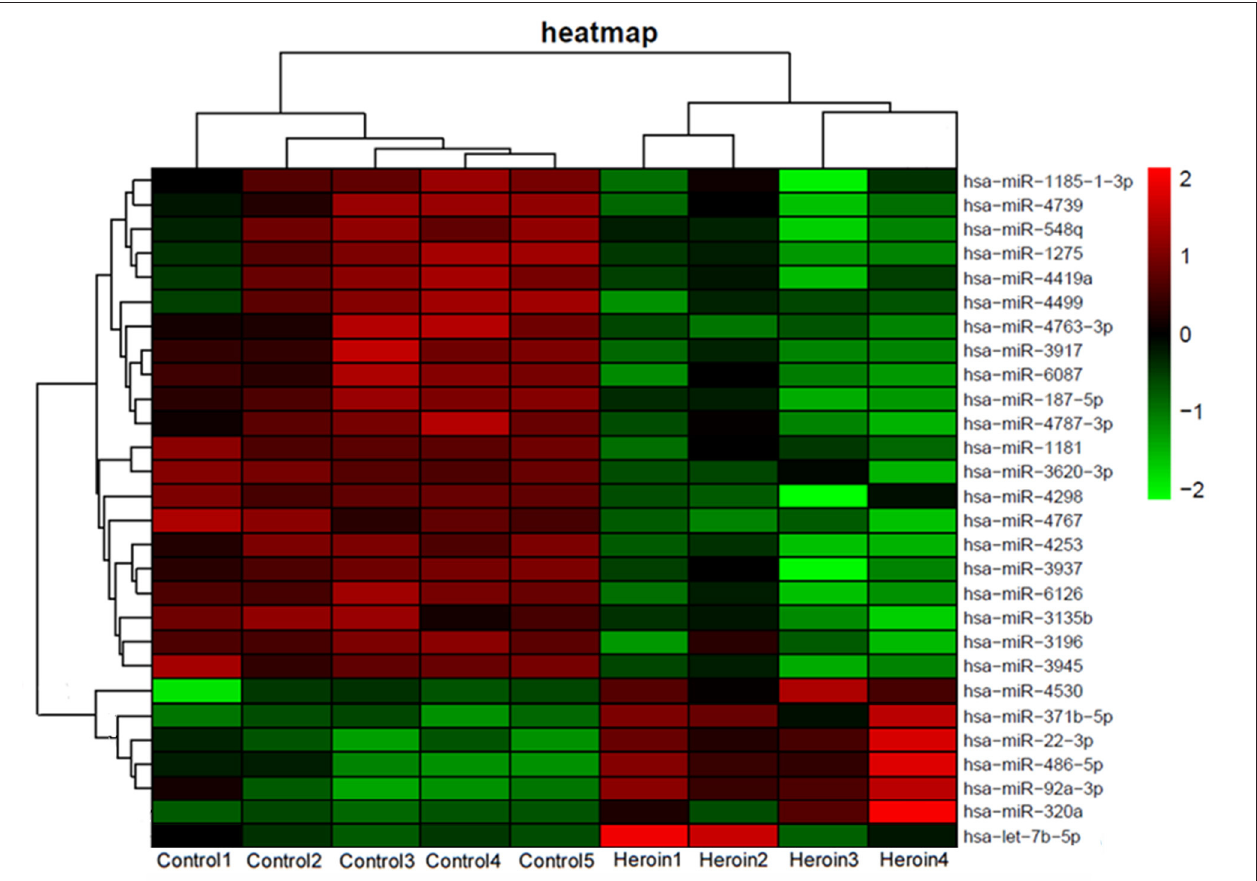
FIGURE 2 | Heat map of miRNA microarray expression data from plasma samples of heroin-dependent patients ( n = 4) and healthy control subjects ( n = 5). MiRNA expression is hierarchically clustered on the y-axis. Each column represents a sample, while each row represents a miRNA. The legend on the right indicates the miRNA represented in the corresponding row. The relative miRNA expression is depicted according to the color scale shown on the right. Red indicates upregulation; and green,